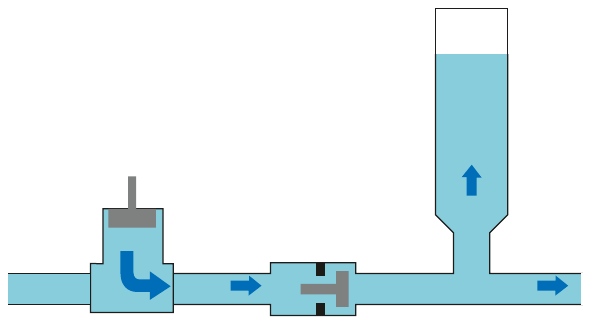
Figure 16: HRP working cycle: a pumping period.